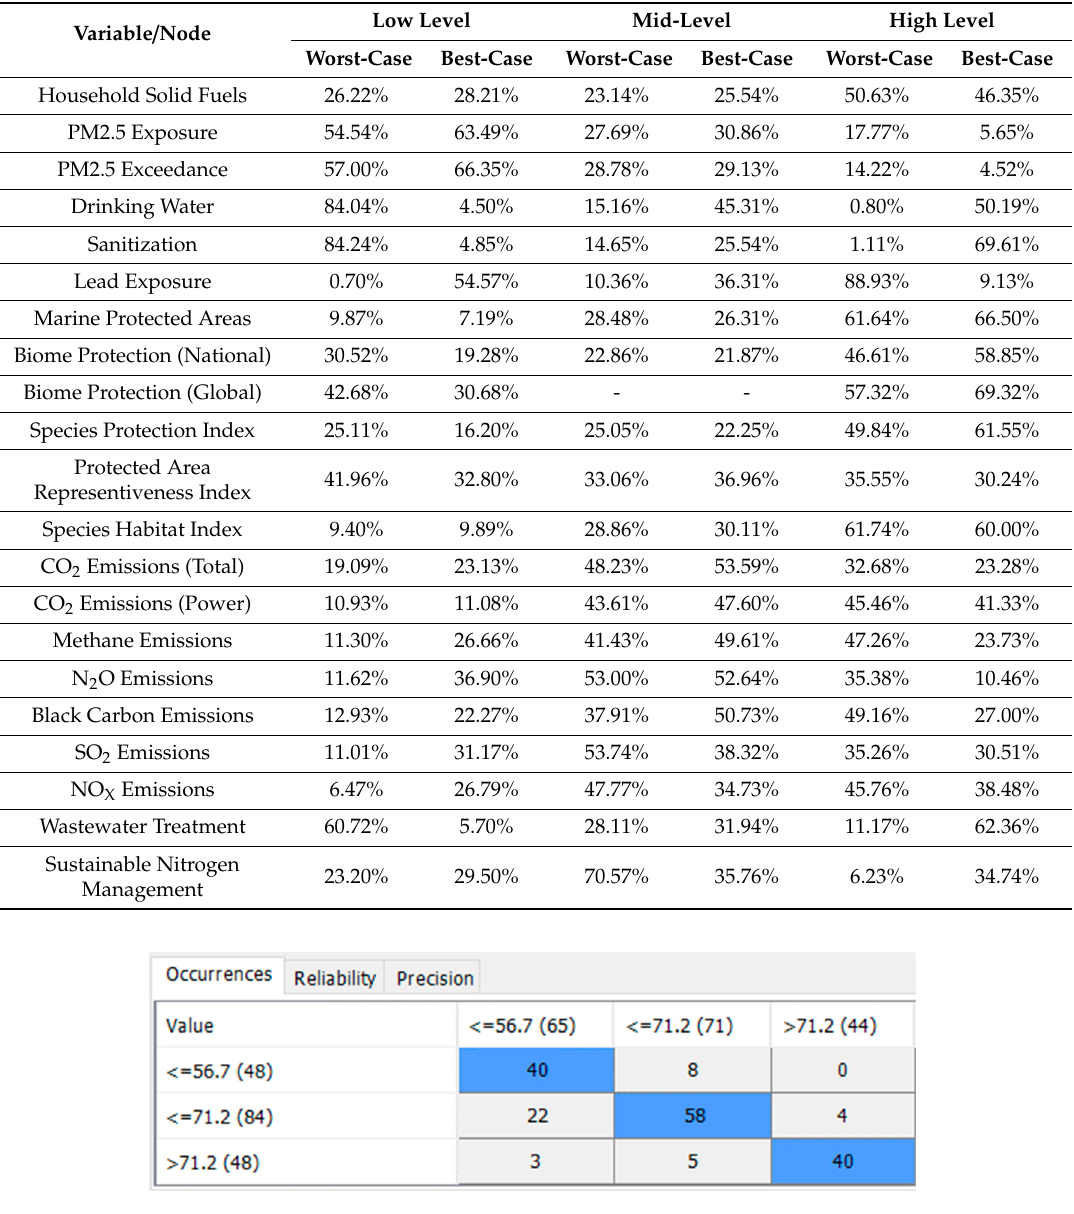
Table 5. Comparison of worst- and best-case scenarios.